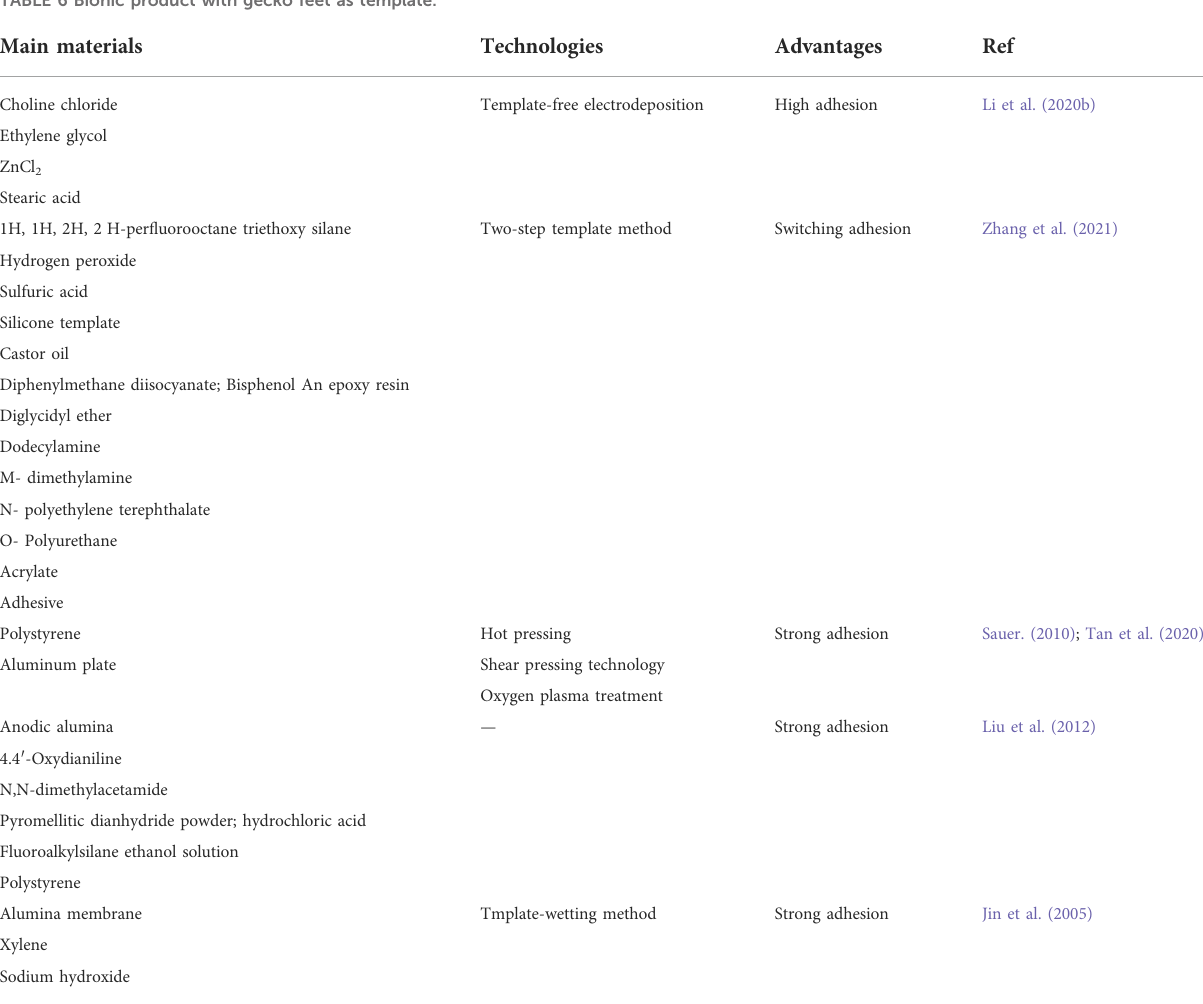
TABLE 6 Bionic product with gecko feet as